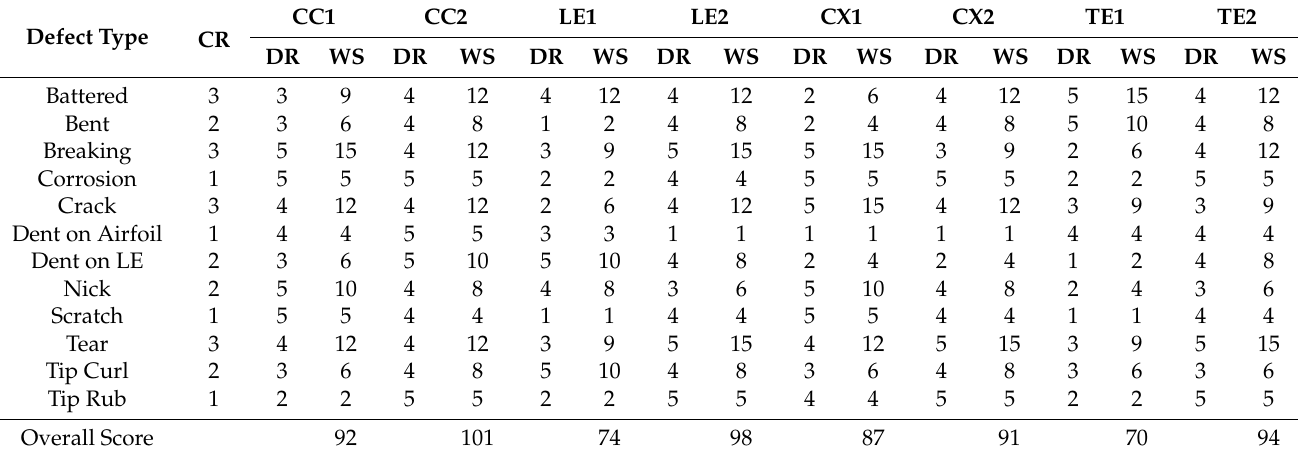
Table 13. Weighted factor analysis for different viewing